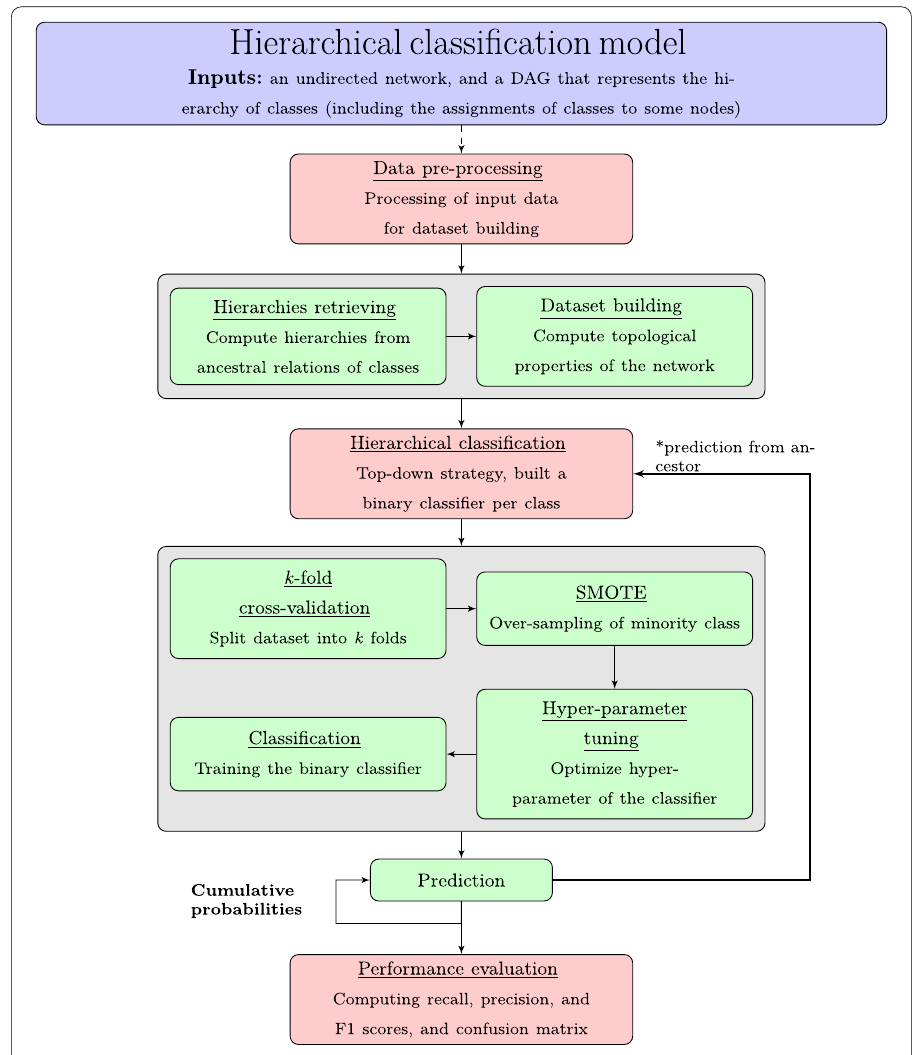
Fig. 2 Framework of the hierarchical multi-label classification approach. The approach is split into three stages: data pre-processing, class prediction and performance evaluation. The approach is applied for every resulting sub-hierarchy H ′ independently. Ancestral relations between classes are included in the model as features with the prediction of ancestors and are represented by the upward arrow in the prediction stage. In addition, a correction mechanism for inconsistencies is included by means of cumulative probabilities, which are computed according to the path of classes in the sub-hierarchy. If the probability of association between a node and a class is close to zero, then the cumulative probability of the association between the same node and the descendant classes will be close to zero as